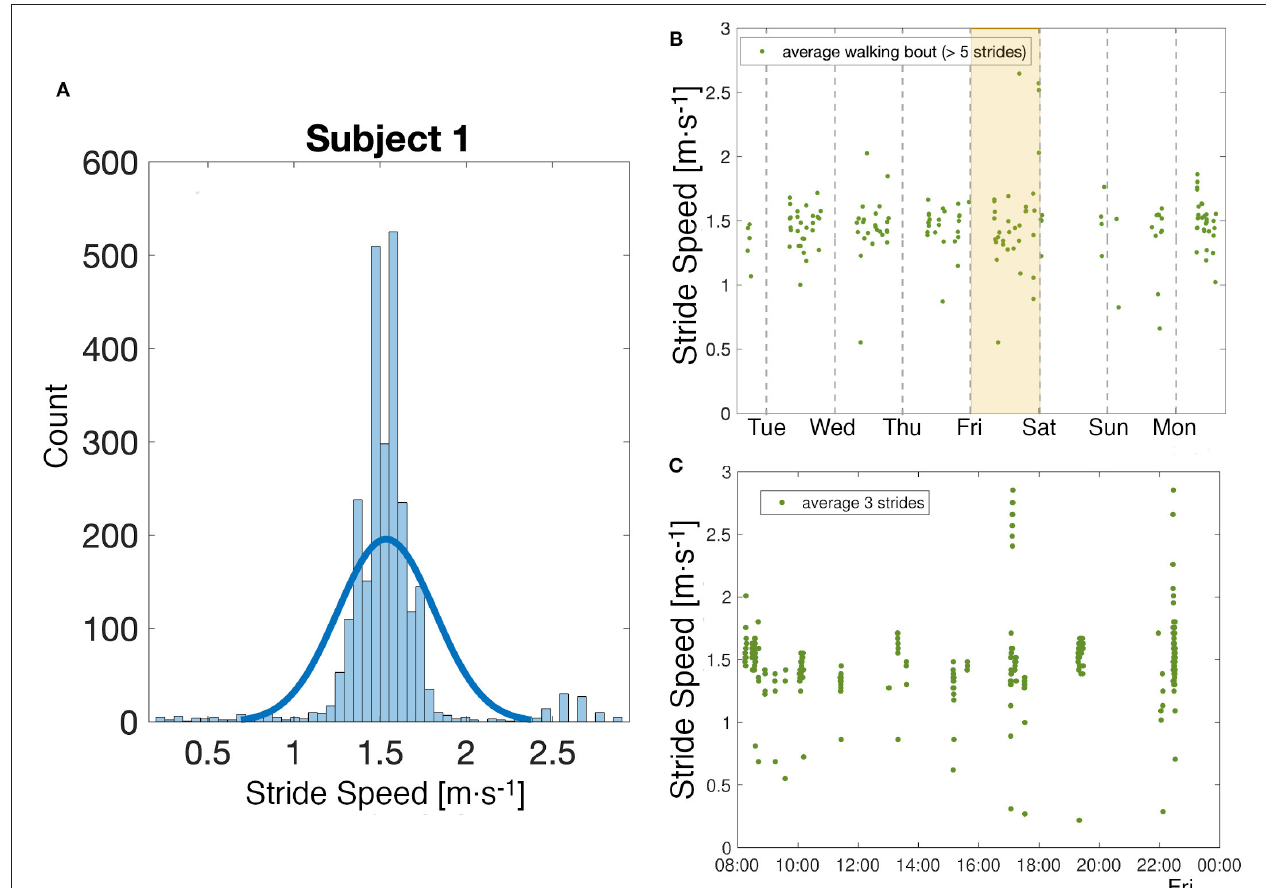
FIGURE 6 | Week analysis. (A) Analysis of the distribution of all stride speed values collected over a week for one subject. (B) Observation of the evolution of walking speed in a week. Each point corresponds to the average of the values of stride speed in a quasi-steady-state walking bout as defined in Methods. (C) A closer look at the values of stride speed on a particular day, shaded in yellow in the figure above. Each point corresponds to the average of three strides.